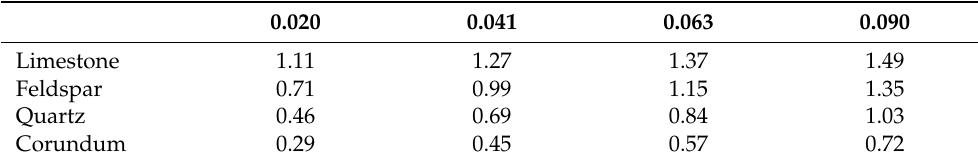
Table 14. Calculated k THD indexes (%) according to Equation (9).